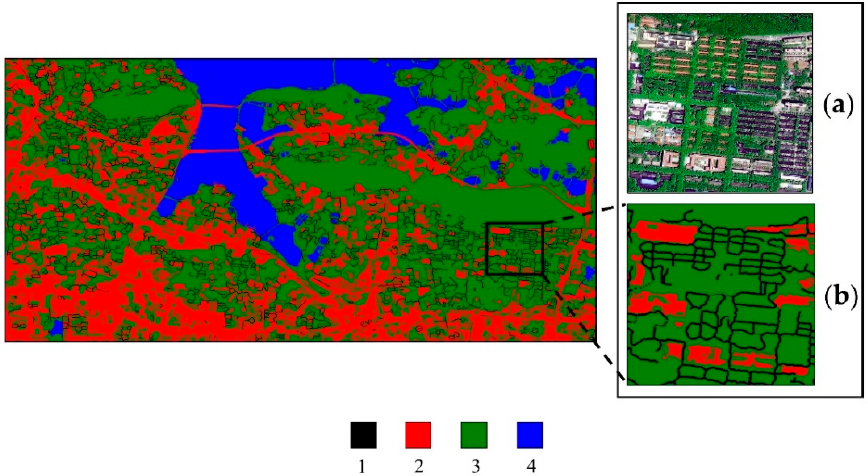
Figure 17. Fusion of ISAs from the proposed algorithm and deep learning: ( a ) GF-2 image; ( b ) vegetation-obscured ISAs and result from deep learning. 1, vegetation-obscured ISAs from the proposed algorithm, 2, ISAs from deep learning, 3, pervious surface area from deep learning, 4, water.